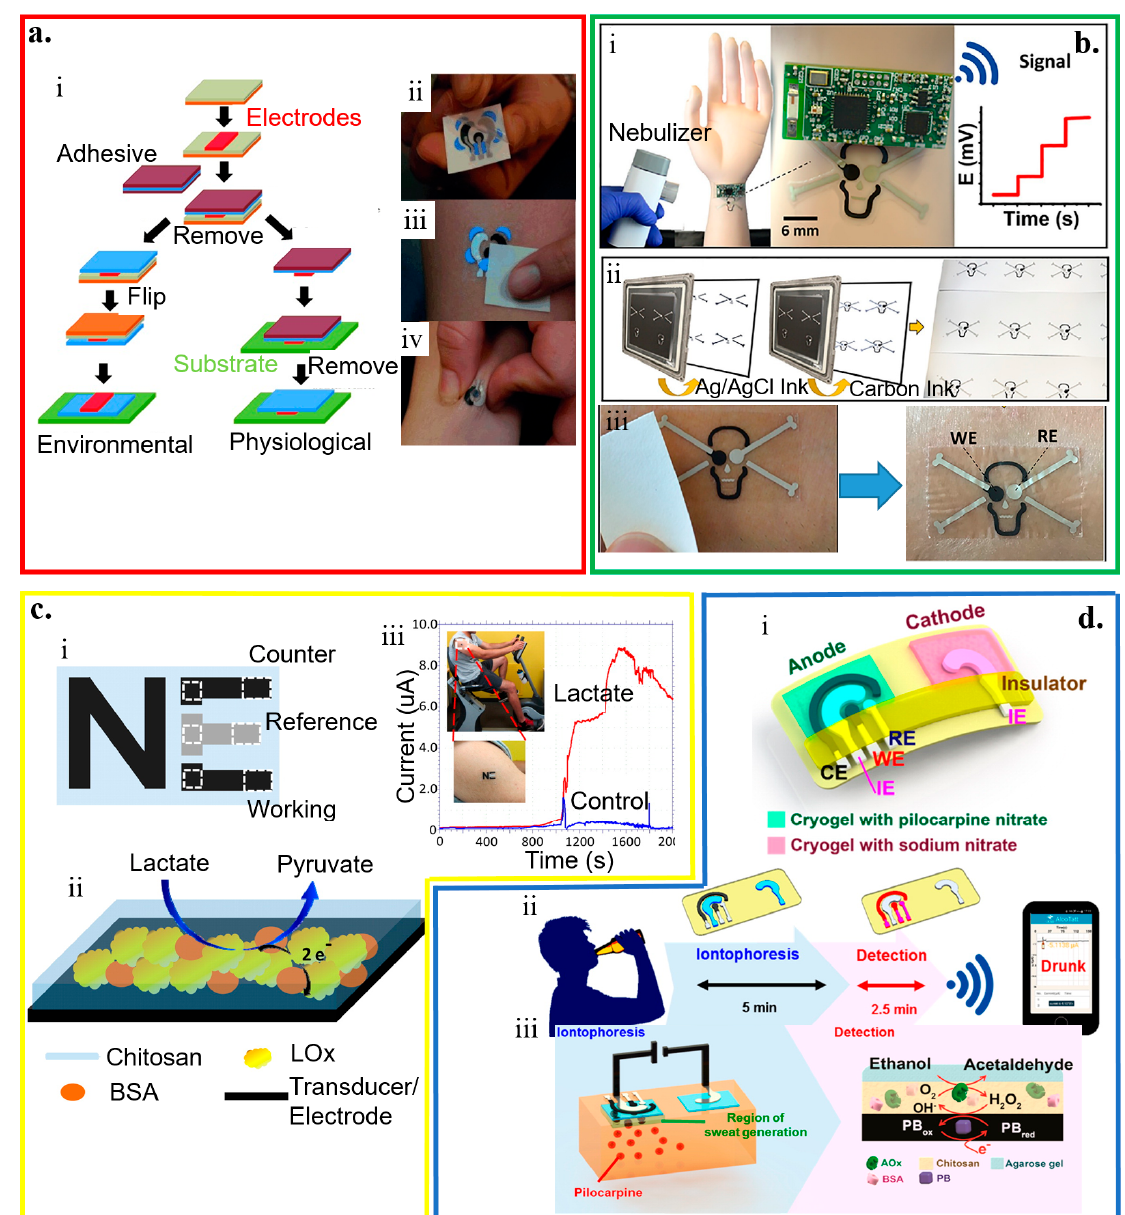
Figure 8. Temporary tattoo-based wearable electrochemical biosensors. ( a ) (i) Schematic and (ii–iv) optical images of the processes to prepare temporary transfer on-skin tattoo-like electrochemical sensor; reproduced with permission from [57], Copyright 2012, The Royal Society of Chemistry. ( b ) Tattoo-like biosensor for detecting nerve agents: (i) Image of the integrated potentiometric biosensor system placed on the mannequin for wireless signal transmission with schematics to show (ii) sensors printed on the tattoo paper and optical images to show (iii) sensors transferred to the skin after removal of the protective layer; reproduced with permission from [175], Copyright 2018, Elsevier. ( c ) (i) Schematic illustration of a three-electrode “NE” tattoo-like electrochemical sensor to detect epidermal lactate, with its (ii) working principle and (iii) demonstration of sweat lactate monitoring during cycling exercise; reproduced with permission from [60], Copyright 2013, American Chemical Society. ( d ) Tattoo-based transdermal alcohol sensor. (i) Schematic diagram of an iontophoretic-sensing tattoo-like device for transdermal alcohol sensing, as well as schematic diagrams to show (ii) its wireless operation and (iii) constituents in the iontophoretic system; reproduced with permission from [46], Copyright 2016, American Chemical Society.